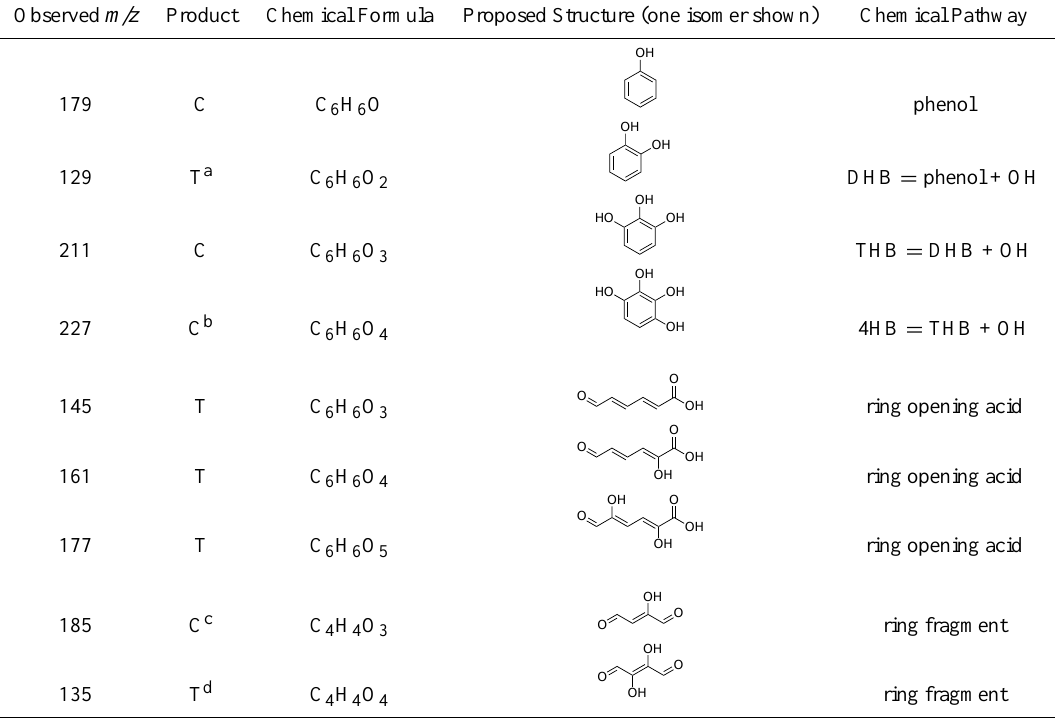
Table 3. Proposed structures for CIMS ions in the phenol low-NO x system. C and T indicate the cluster and transfer product, respectively. Observed m/z Product Chemical Formula Proposed Structure (one isomer shown) Chemical